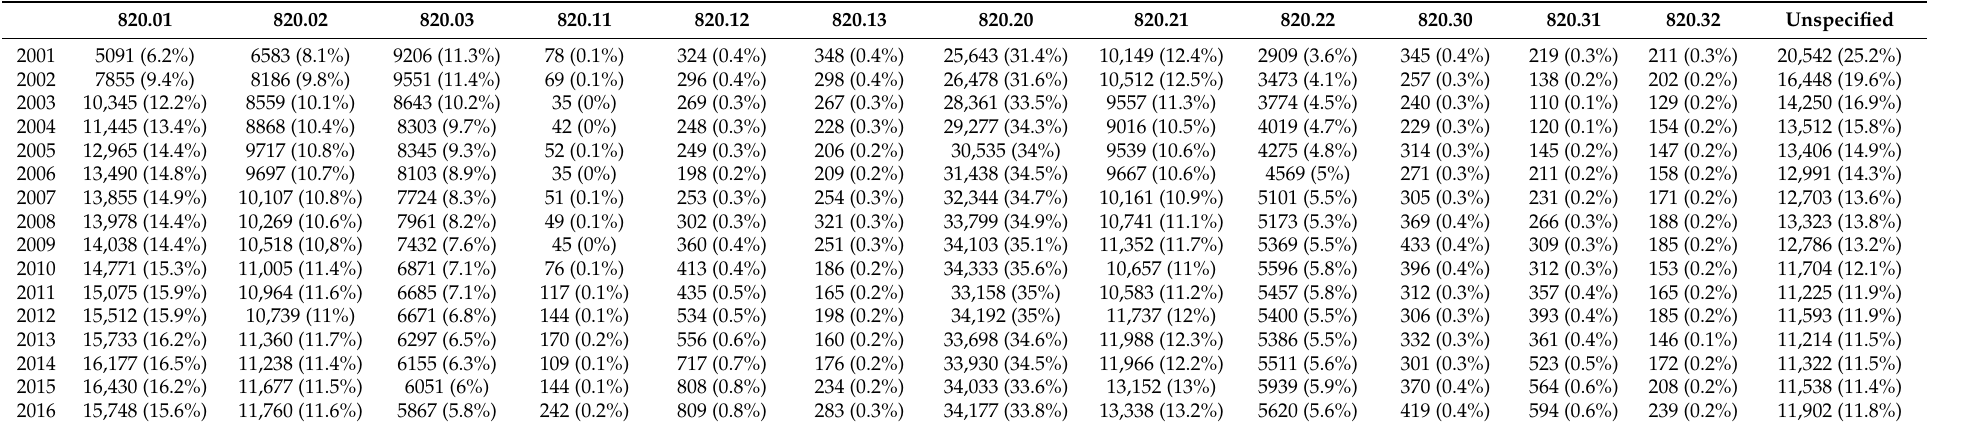
Table 2. Specific diagnosis per